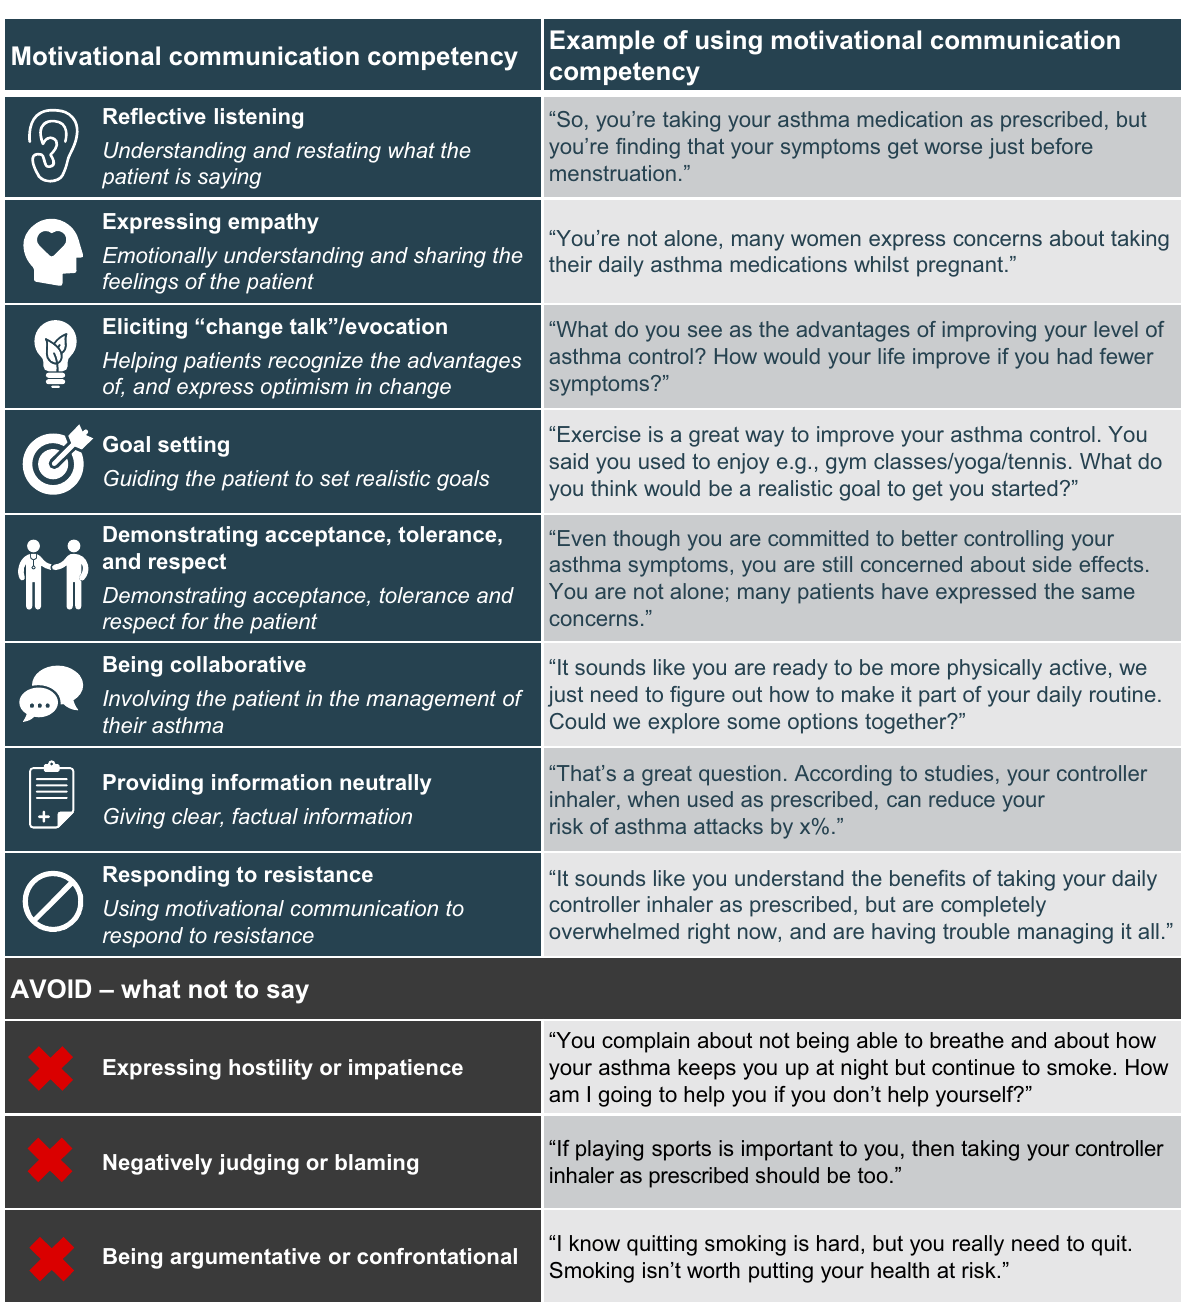
Fig. 2 Motivational communication competencies, de fi nitions, and examples. Adapted from Gosselin Boucher et al. 12 under Creative Commons Attribution license